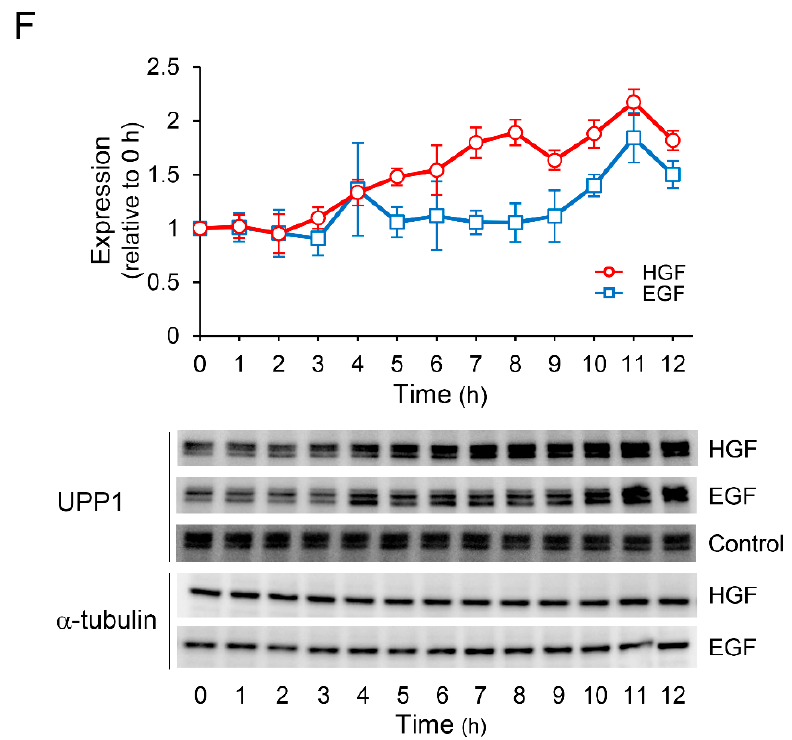
Figure 2. HGF and EGF increase expression of uridine phosphorylase 1 ( UPP1) mRNA and its protein. Metabolism of 5-FU is shown in panel ( A ). DPD, dihydropyrimidine dehydrogenase; OPRT, orotate phosphoribosyl transferase; RRM, ribonucleotide reductase subunit M; TS, thymidylate synthase; TYMP, thymidine phosphorylase; UK, uridine kinase; UPP, uridine phosphorylase; 5-FU, 5- fluorouracil; DHFU, fluorodihydrouracil; dUMP, deoxyuridine monophosphate; dTMP, deoxythymidine monophosphate; dTDP, deoxythymidine diphosphate; dTTP, deoxythymidine triphosphate; FUMP, fluorouridine monophosphate; FUDP, fluorouridine diphosphate; FUTP, fluorouridine triphosphate; FUR, fluorouridine; FUdR, fluorodeoxyuridine; FdUMP, fluorodeoxyuridine monophosphate; FdUDP, fluorodeoxyuridine diphosphate; FdUTP, fluorodeoxyuridine triphosphate. HepG2 cells were incubated with either HGF (50 ng/mL) or EGF (50 ng/mL) for the indicated period. Thereafter, total RNA and protein were extracted. The transcription levels of UPP1 ( B ), UPP2 ( C ), TYMP ( D ), and OPRT ( E ) are expressed as a percentage of that in cells not treated with growth factors at 0 h. Each bar represents the mean ± SD of 5 experiments. Total protein was collected at the indicated time points. The expression level of the UPP1 protein was detected by western blotting. Western blot analysis was performed in 3 experiments for 3 different preparations, and the representative blots are shown. The density of the bands was measured using ImageQuant TL software (Ver. 7.0, EG Healthcare Inc., Chicago, IL, USA). The levels of protein expression quantified by scanning densitometry of the immunopositive protein and corrected for α -tubulin levels in the same samples are represented as a percentage of that in cells not treated with growth factors at 0 h ( F ).